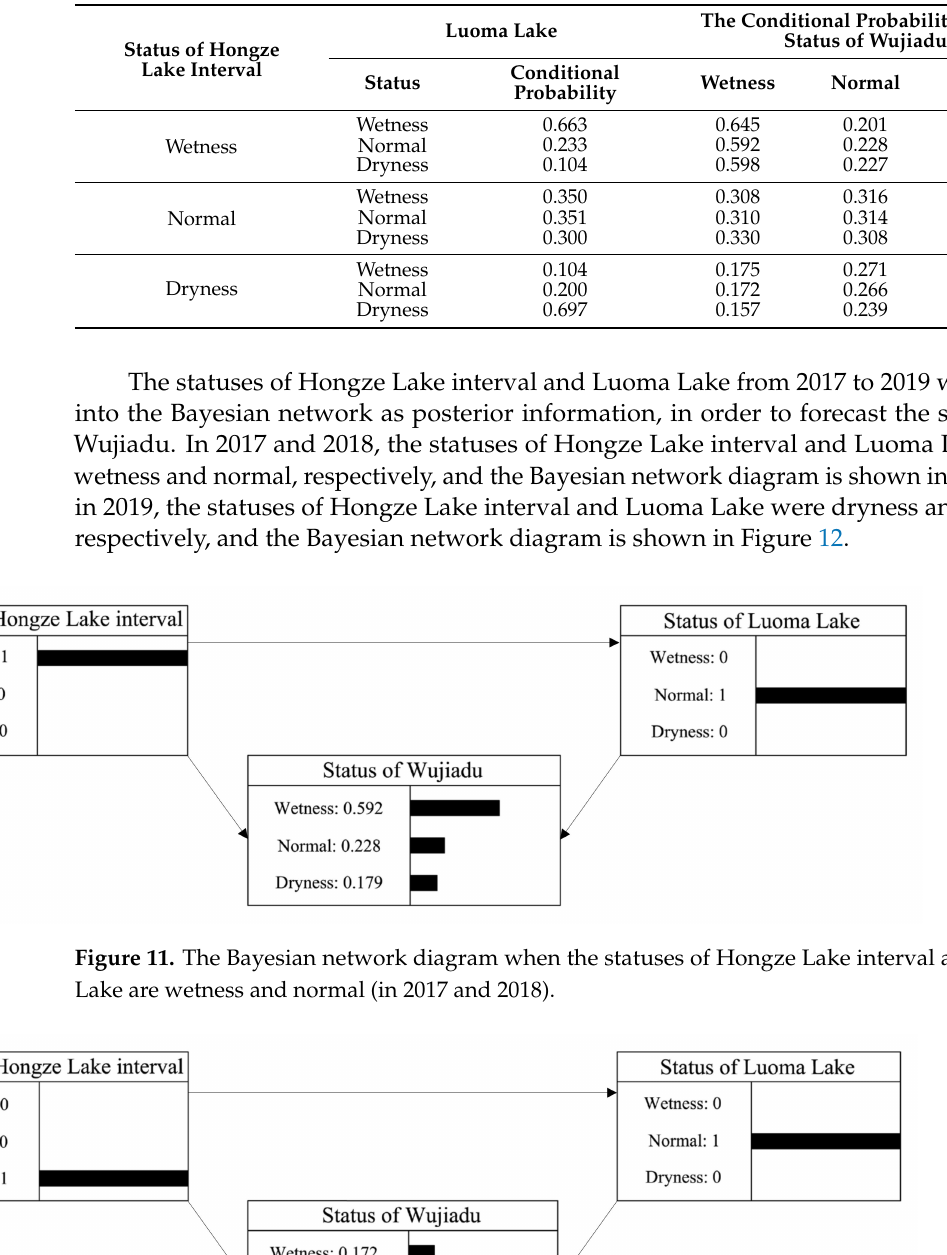
Table 10. The conditional probability table of wetness-dryness encountering.